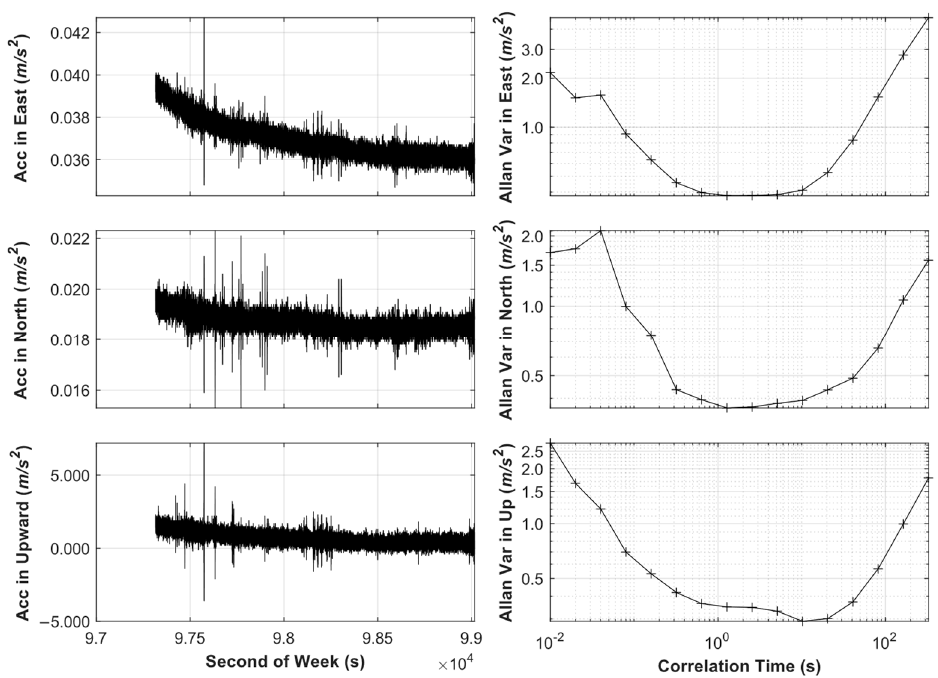
Figure 4. The raw data of the accelerometer stationary observation ( left ) and the log–log plot of Allan variance ( right ). Table 2. The calibration results of the three-axis acceleration random walk coefficient (unit: m/s 2 ·sqrt (Hz)).